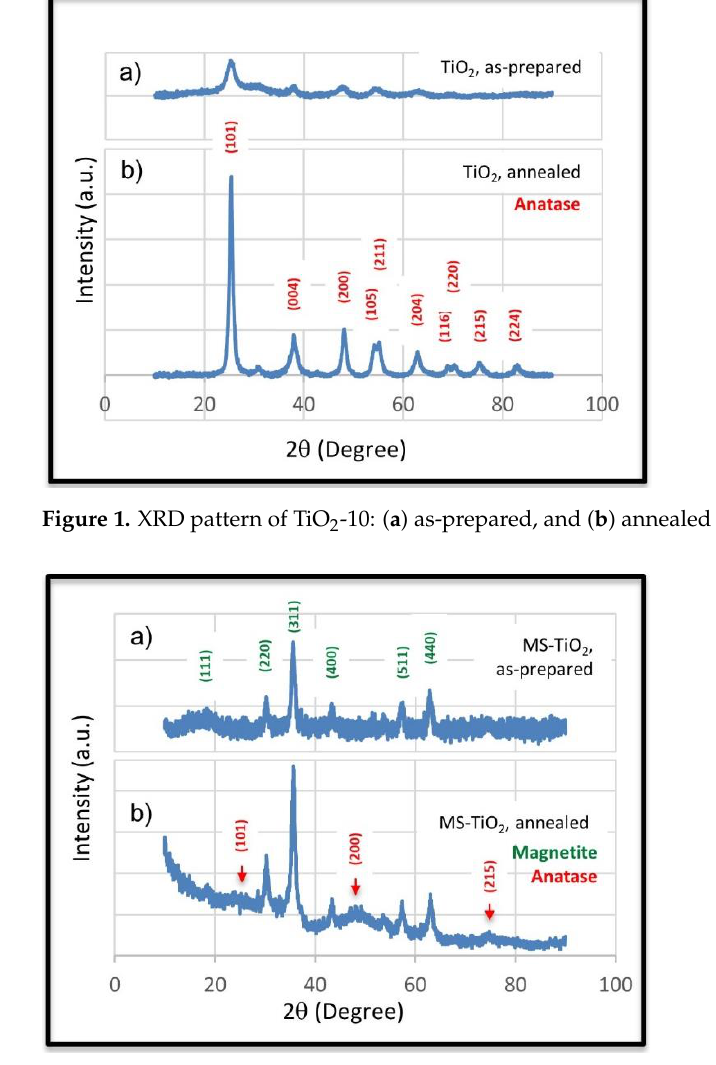
Figure 2. XRD pattern of MS-TiO 2 -10: ( a ) as-prepared, and ( b ) annealed at 300 °C.